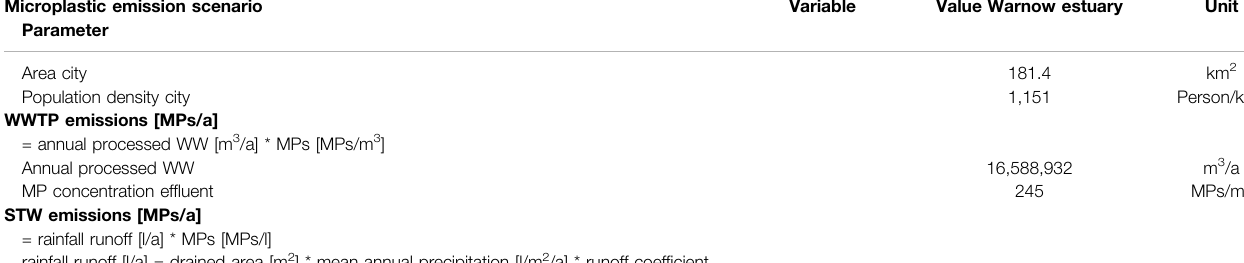
TABLE 6 | Parameters for microplastic (MP) emission scenarios for the sewer system. WWTP: wastewater treatment plant, CSO: combined sewer over fl ow, STW: stormwater, WW: wastewater, TRWP: tire and road wear particles. Data sources for utilized MP concentrations are provided within Supplementary Table SI1 ). Microplastic emission scenario